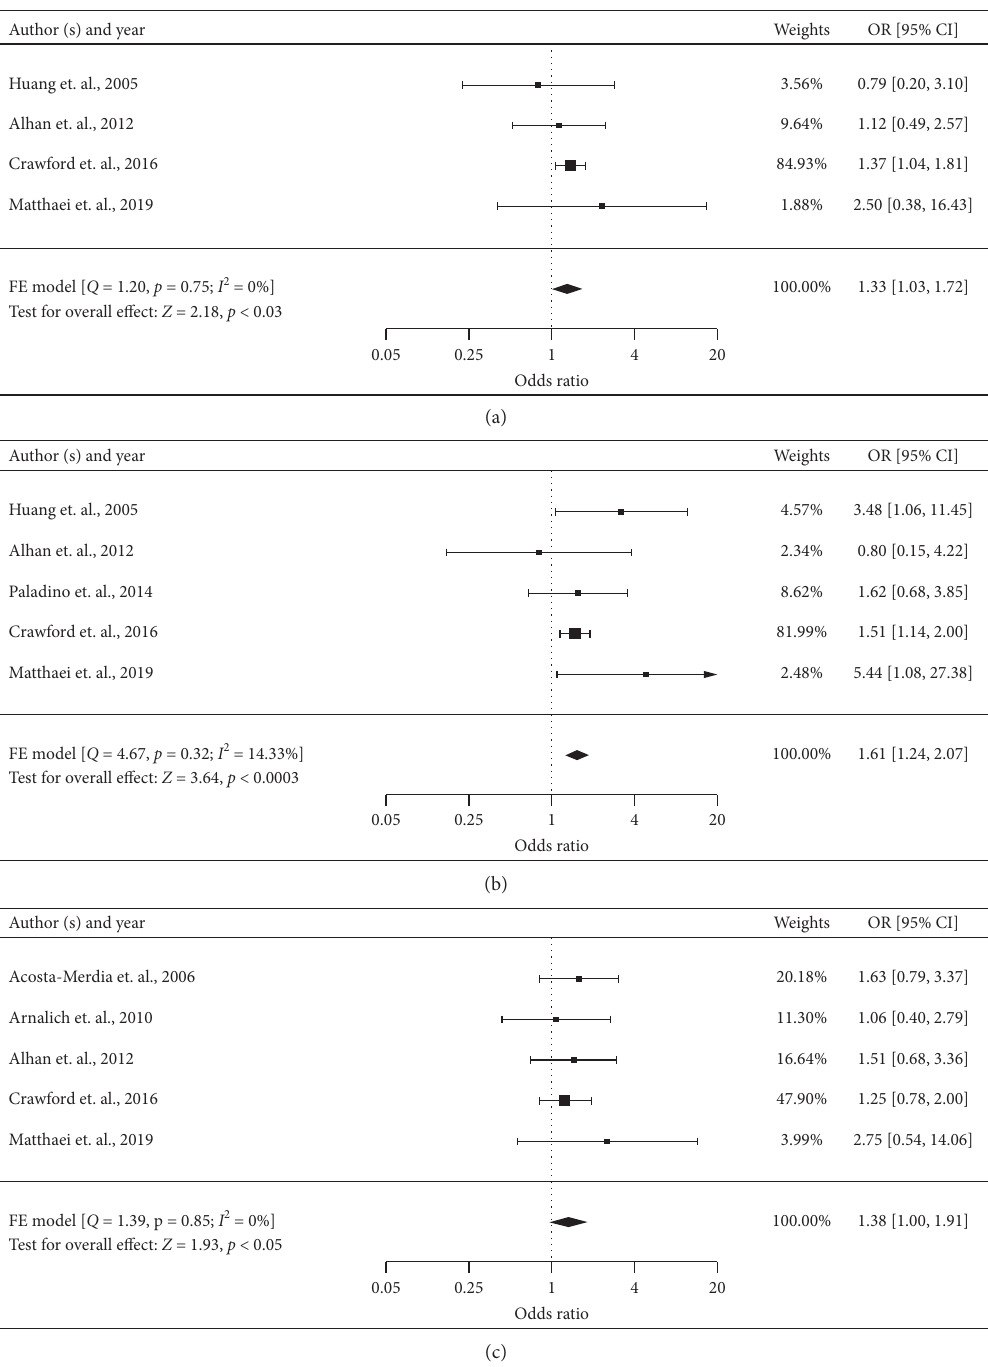
Figure 3: Forest plots for significant preoperative risk factors for short-term postoperative mortality of AMI after laparotomy with data available in at least four studies (comorbidities). Notes: renal disorders include renal failure and chronic renal disease. FE: fixed effect; RE: random effect. (a) Heart failure (categorical variable), (b) renal disorders (categorical variable), and (c) peripheral vascular disease (categorical